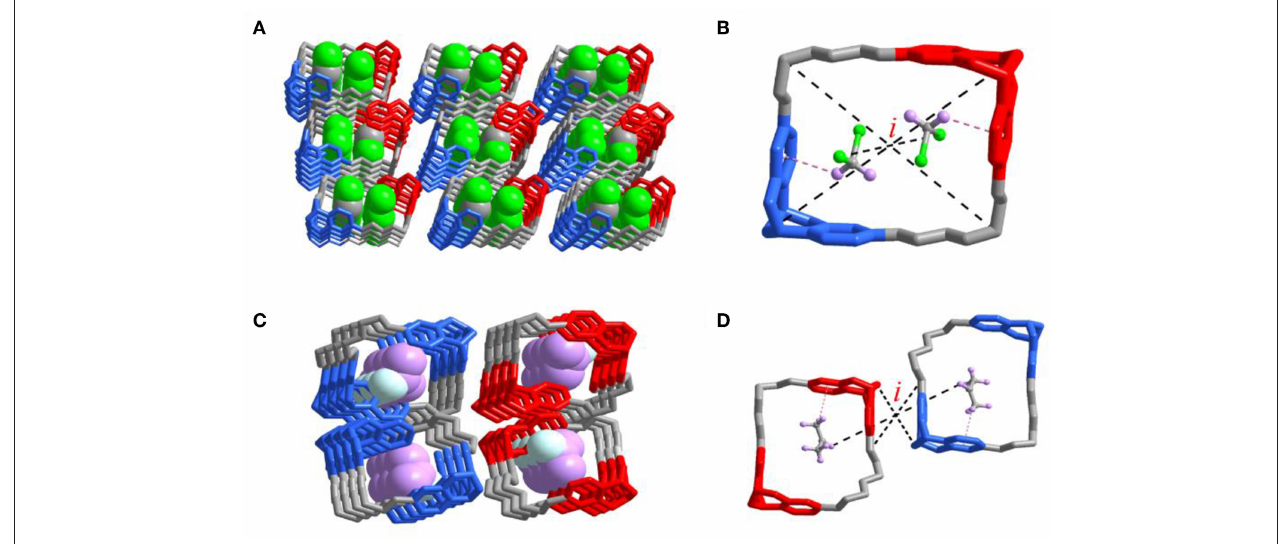
FIGURE 6 | Single-crystal X-ray structures of the complexes (A) 2DCM @ R 2 N S 2 N -T1 , two dichloromethane molecules were bound within the cavity. (B) Pink dashed lines indicate the [C-H ··· π ] interactions and R 2 N S 2 N -T1 encapsulated two dichloromethane molecules. Corresponding guest molecule structural formulas: C, gray; H, pink; Cl, green. (C) 2 acetone @ rac- T1 , two acetone molecules are bound within the cavity of S 4 N -T1 and R 4 N -T1 , respectively. (D) Pink dashed lines indicate the [C-H ··· π ] interactions and rac -T1 encapsulated two acetone molecules. Corresponding guest molecule structural formulas: C, gray; H, pink; O, turquoise. i: inversion